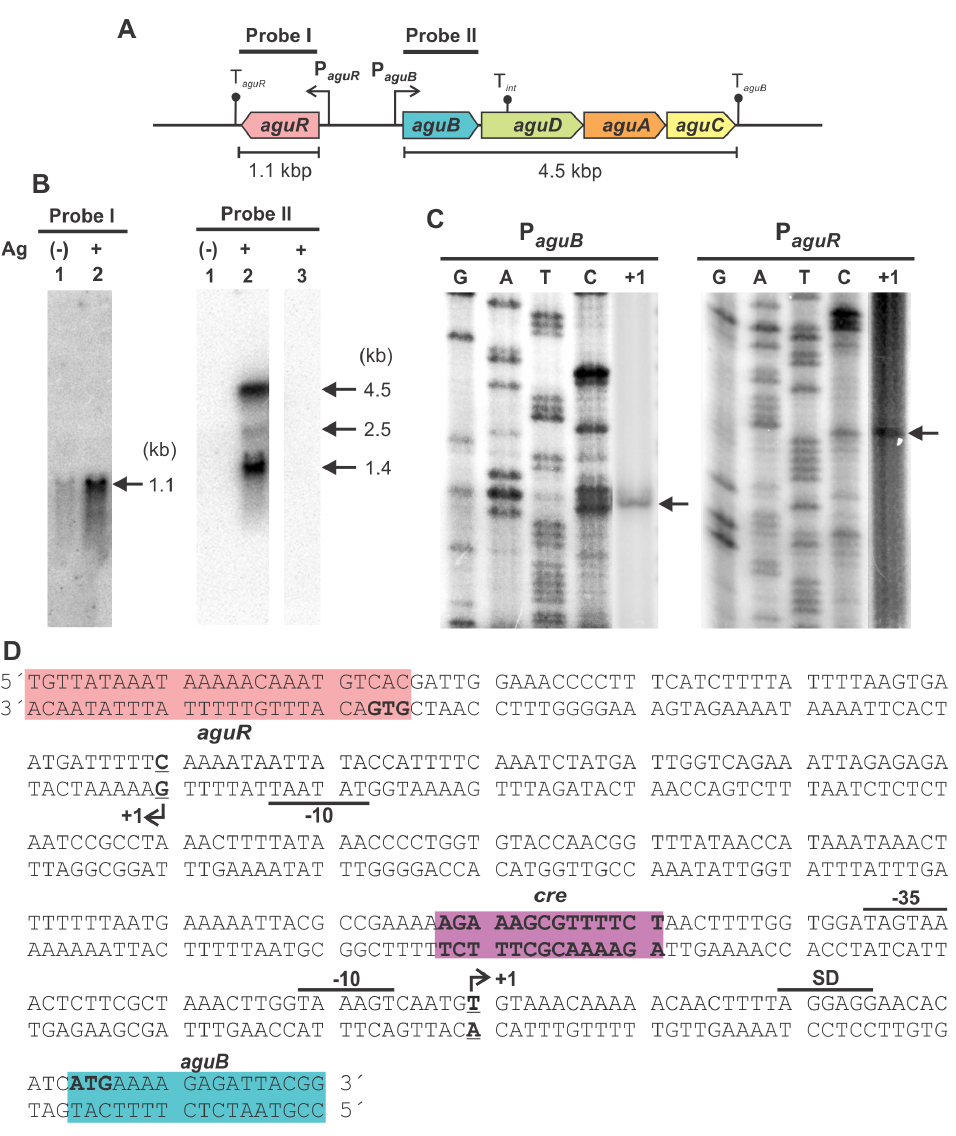
Figure 3. Transcriptional analysis of agu genes in E.faecalis. A) Schematic representation of agu operons. P aguR and P aguB indicate promoter regions. Secondary structures T aguR and T aguB represent putative Rho-independent transcriptional terminators. B) Northern blot analysis. E. faecalis wild-type (lanes 1 and 2) or aguR (lane 3) cells were grown in LB Gal with or without agmatine (Ag). Total RNA (extracted after 6 h of growth) was hybridized against specific probes I or II. Transcript size was determined by comparison to RNA markers. C) Primer extension experiments for the determination of aguR and aguB transcriptional start sites (lanes + 1). Lanes G, A, C and T show homologous sequence ladders. D) Nucleotide sequence of aguR-aguBDAC intergenic region. Positions of transcriptional start sites are indicated ( + 1). Putative Shine-Dalgarno (SD), 2 10 and 2 35 regions are shown underlined. Translational start sites are shown in bold. The predicted cre site is highlighted in purple.